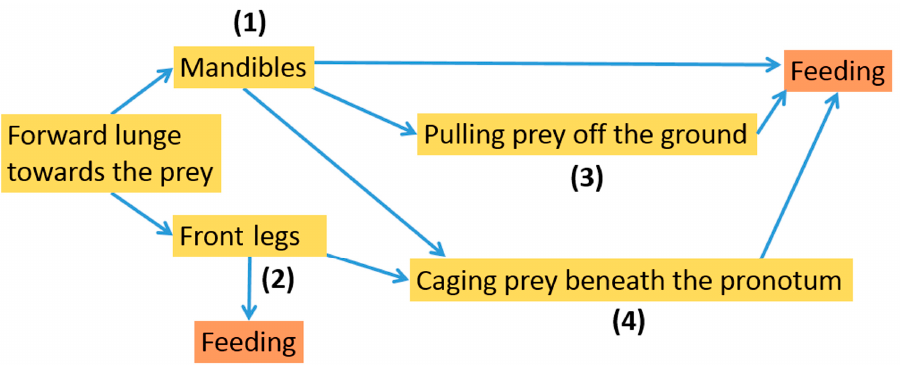
Figure 22. Flow diagram illustrating the inferred pathway of observed prey-capture patterns with their possible combinations and sequences. Source: their possible combinations and sequences. Source: [47].